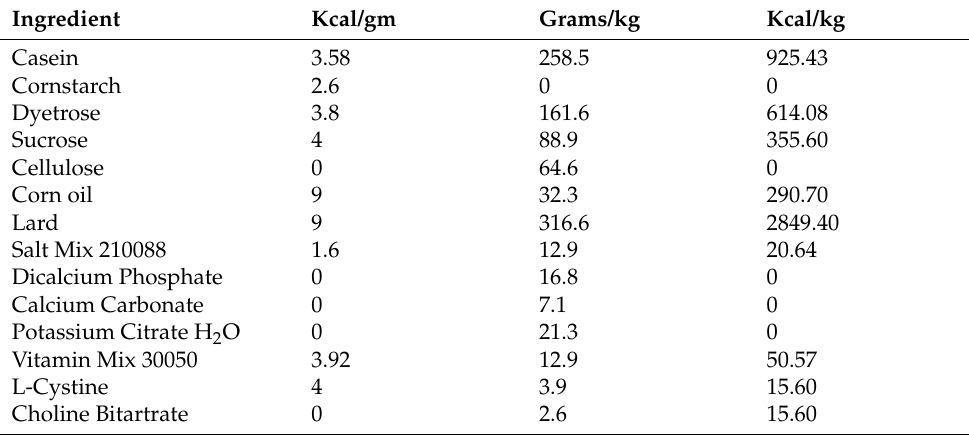
Table 1. Customized high-fat diet